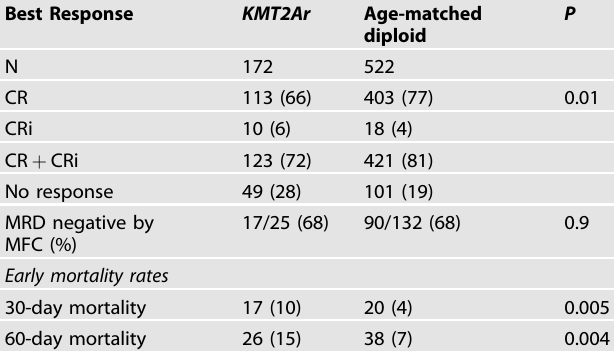
Table 2. Response and early mortality rates of newly diagnosed adults with